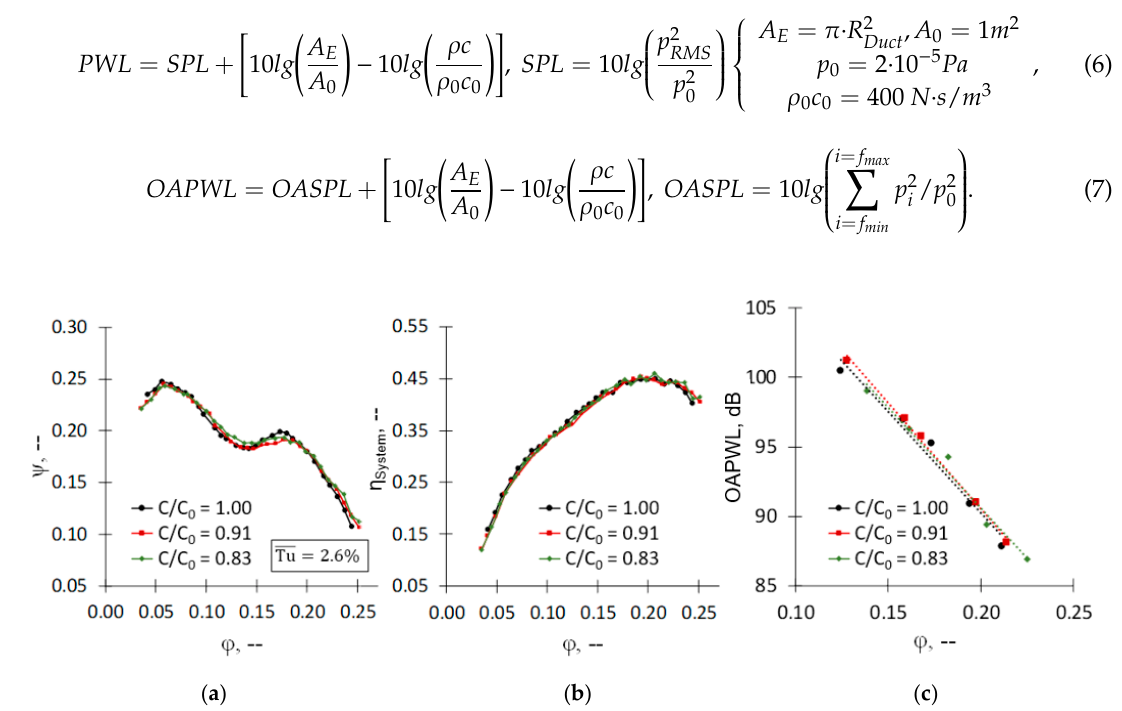
Figure 6. Validation of scaling approach by varying the chord length C of the baseline blades with C 0 = 75 mm. ( a ) Non-dimensional static pressure rise ψ ; ( b ) Aerodynamic efficiency η ; ( c ) Overall sound power level OAPWL (Equation (7)).